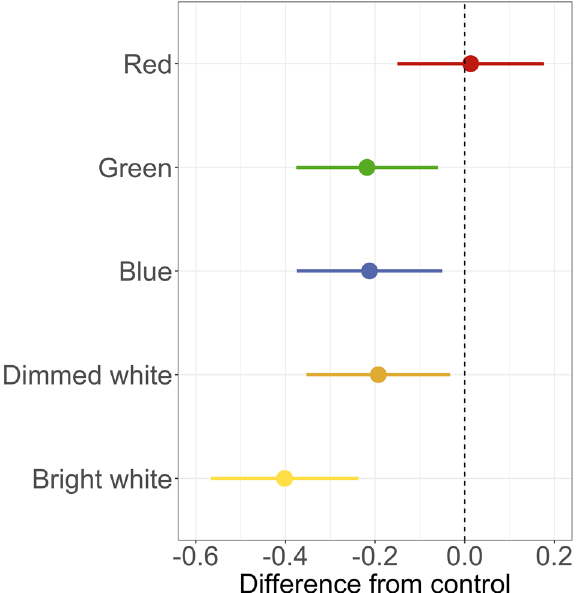
Figure 3. Results of post-hoc tests in the spectra experiment. The graph shows the estimated coefficients and 95% confidence interval of five experimental pairs when comparing the difference in ‘light-on’ vs ‘light-off’ to the control (‘light-off’ vs ‘light-off’, dashed vertical line). All the colours except red significantly reduced bird counts, with lower numbers of birds recorded when the light was on. For detailed statistics, see Table